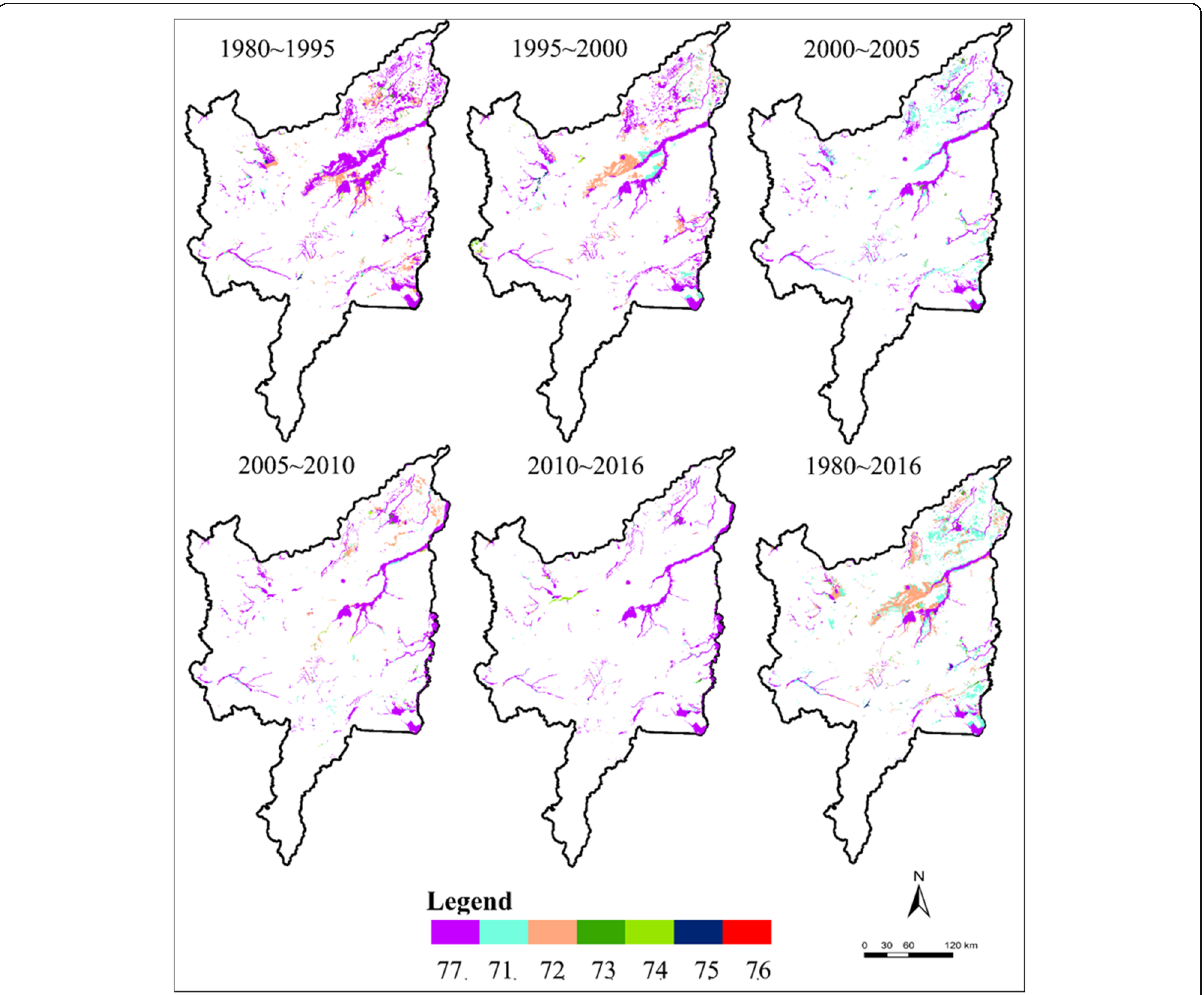
Fig. 4 Marshland transitions in the study area during 1980 – 2016. Notes: 71, marshland converted to paddy field; 72, marshland converted to